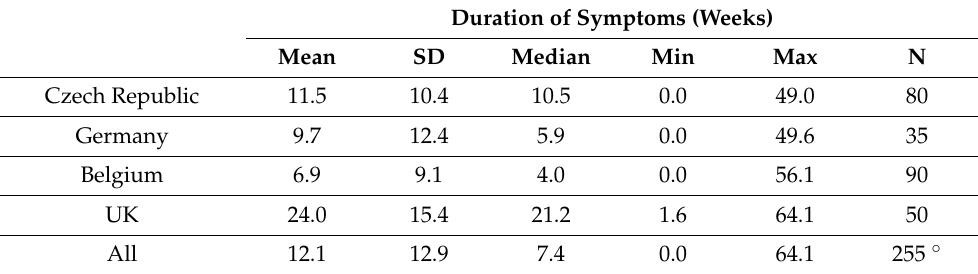
(Table 5: Feeding per